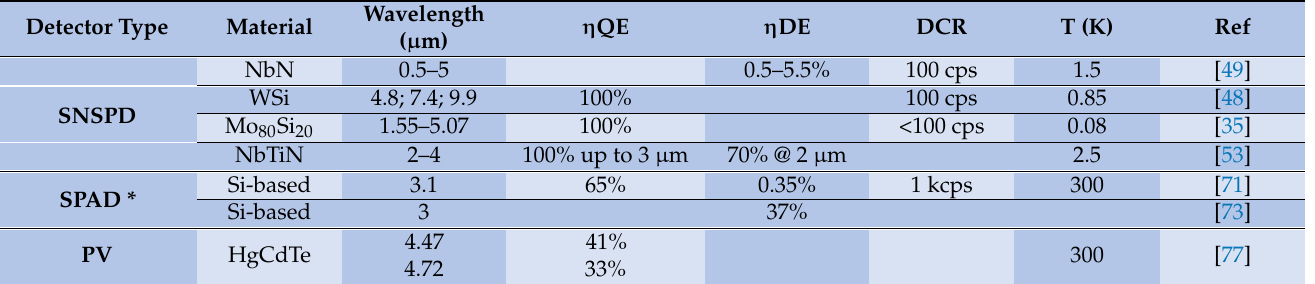
Table 1. Overview and comparison of SNSPD, SPAD, and PV detectors. Upconversion detection is highlighted with